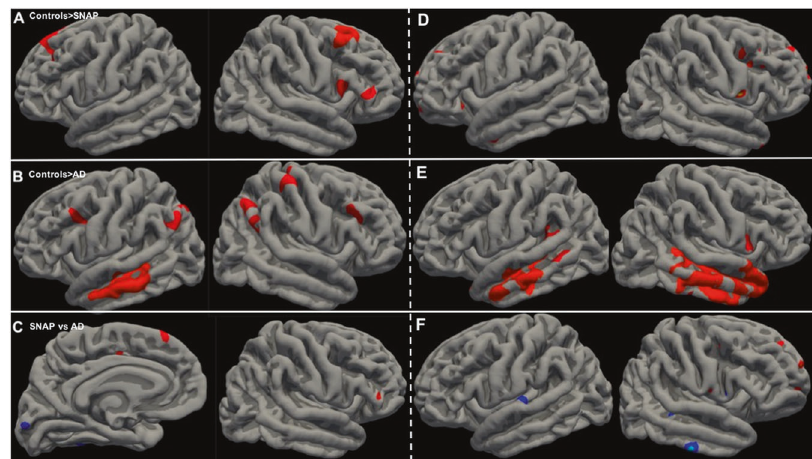
Fig. 3 Vertexwise comparisons of cortical thickness between groups. Vertexwise comparison of baseline cortical thickness controlled for age showed lower thickness in: A SNAP patients compared with controls (clusterwise correction for multiple comparisons, p < 0.05); B AD patients compared with controls (clusterwise correction for multiple comparisons, p < 0.05); and C SNAP patients (in red) and AD patients (in blue) when compared to each other (medial view of the left hemisphere and lateral view of the right hemisphere, p < 0.001, uncorrected). Vertexwise comparison of the symmetrized percent change of cortical thickness controlled for age after 2 years showed a higher decrease in: D SNAP patients vs controls ( p < 0.001, uncorrected); E AD patients vs controls (clusterwise correction for multiple comparisons, p < 0.05); and F SNAP patients (in red) and AD patients (in blue) when compared to each other (clusterwise correction for multiple comparisons, p < 0.05 in the left hemisphere, and p < 0.001, uncorrected in the right